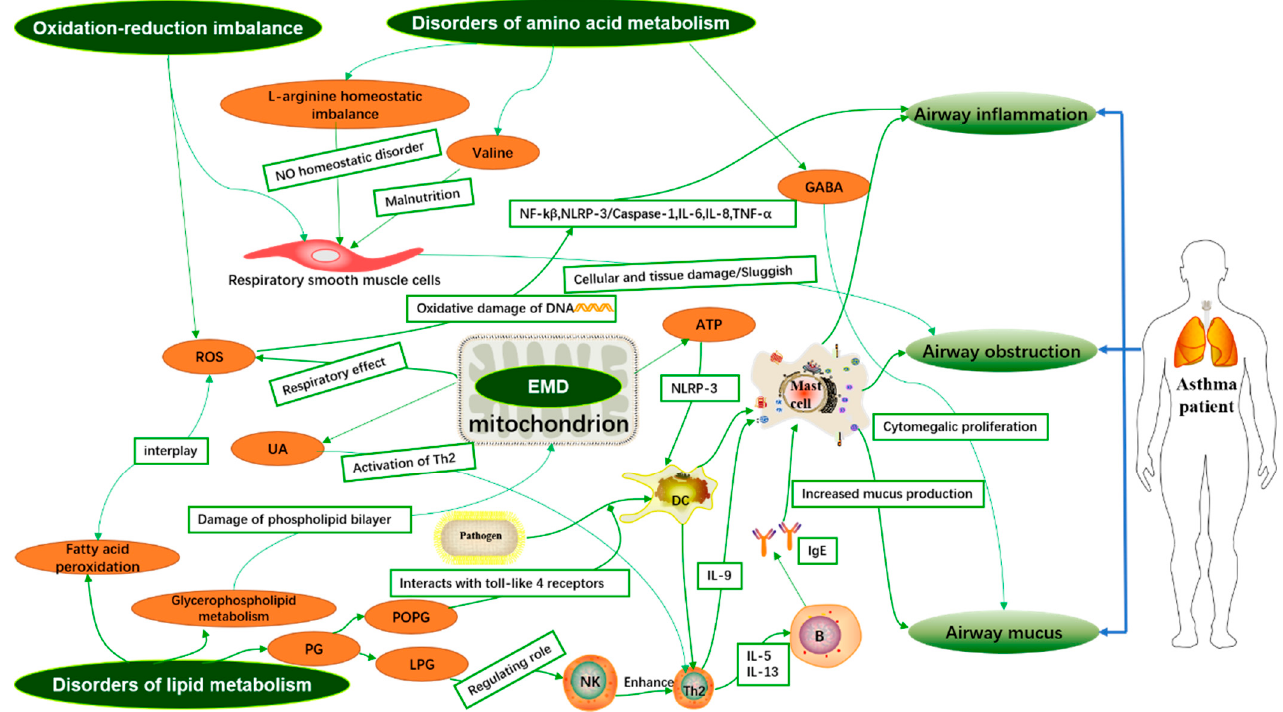
Figure 1. Mechanism of asthma based on metabolites. Disturbances in lipid metabolism, amino acid metabolism, energy metabolism, and oxidative–oxidative imbalance lead to inflammation and oxidative stress, which may be involved in the development of asthma. GABA: gamma-aminobutyric acid; NF- κ B: Enhanced κ -light chain in nuclear factor-activated B cells. NLRP-3: nod-like receptor family pyrin domain containing 3; IL-6: interleukin-6; IL-8: interleukin-8; IL-5: interleukin-5; IL-13: interleukin-13; IL-9: interleukin-9; IgE: Immunoglobulin E; TNF- α : Tumor Necrosis Factor α ; ROS: reactive oxygen species; NK: natural killer cell; Th2: T helper 2 cell.